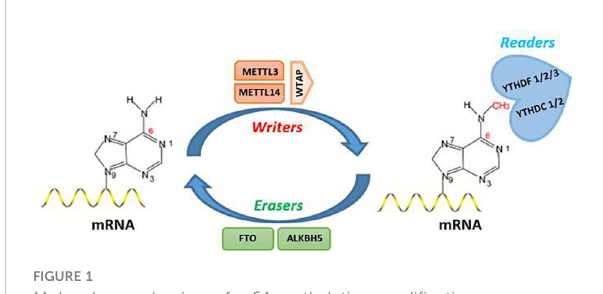
FIGURE 1 Molecular mechanism of m6A methylation modi fi